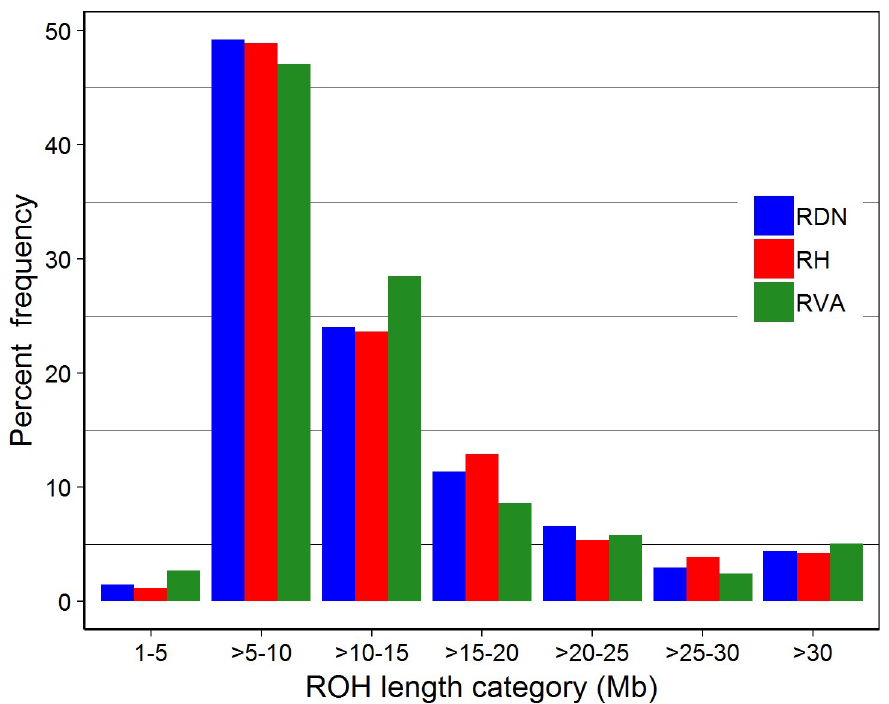
Fig 3. Frequency distribution of the number of ROH in different length classes for Angler (RVA), Red-and-White dual-purpose (RDN) and Red Holstein (RH).